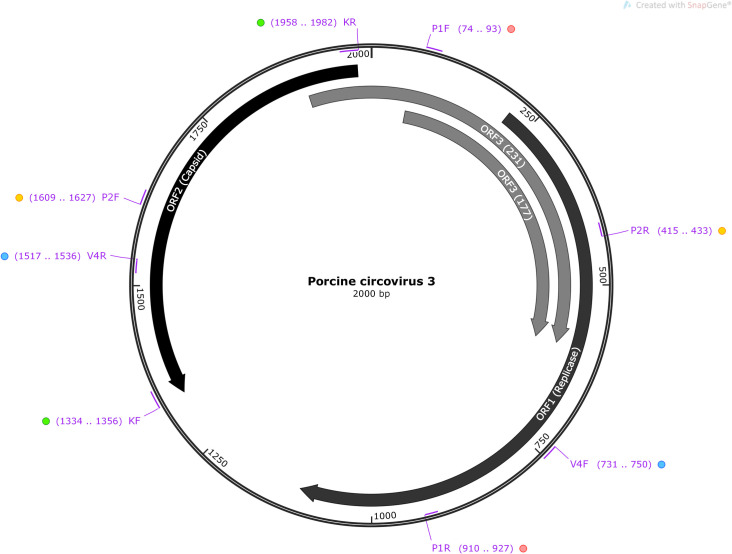
Schematic representation of primer pairs used in this study to generate complete genome sequence of PCV3.